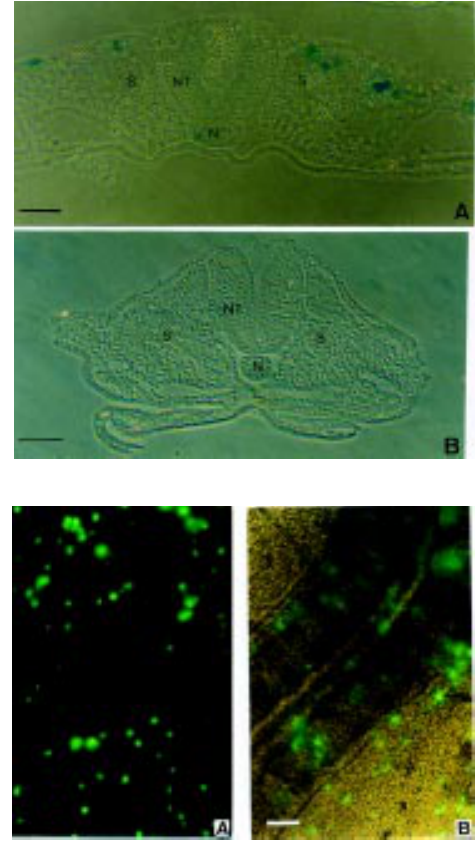
Figure 2. Transverse section of the medial embryo region. Em- bryo bombarded under optimal conditions, displaying ß-galac- tosidase expression in the first layers of the somite (A). B , Non- bombarded embryo. NT, neural tube; N, notochord; S, somite. Scale bars = 100 µm.